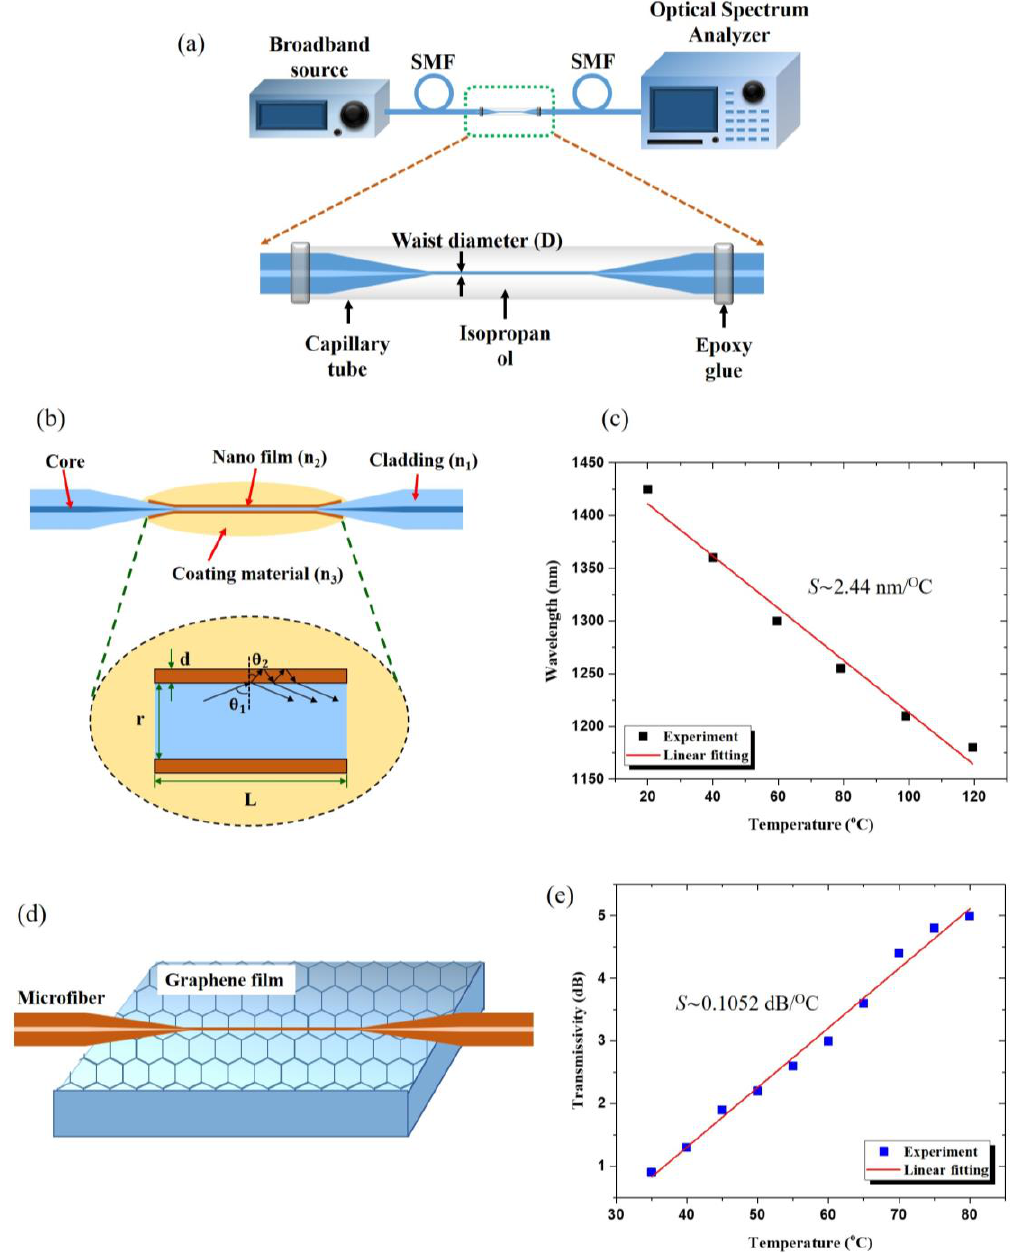
Figure 10. ( a ) Schematic diagram of isopropanol-sealed capillary. ( b ) Schematic diagram of the MF coated with the high refractive index Al 2 O 3 nanofilm. ( c ) Dependence of the resonant wavelength shift of metal nanofilm coated MF for increasing temperatures. ( d ) Schematic diagram of graphene assisted MF (GAMF). ( e ) Transmissivity change of the GAMF for increasing temperatures.